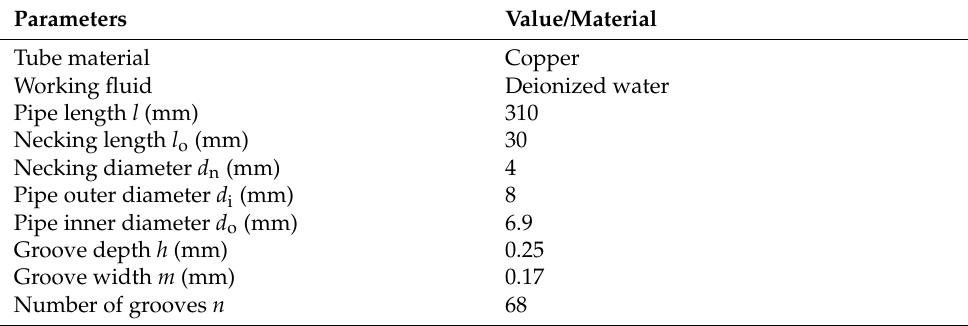
Table 1. The geometric parameters of grooved heat